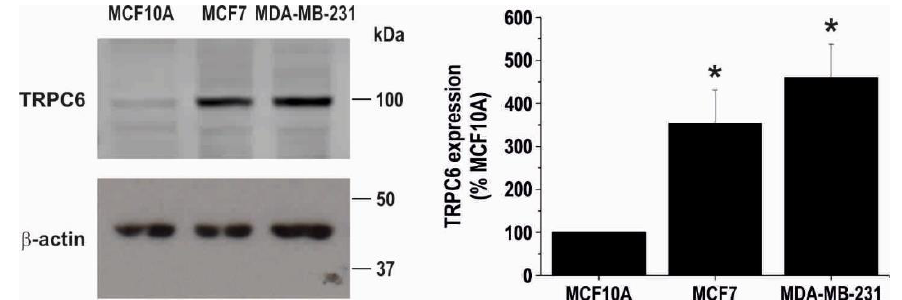
Figure 1. Cellular expression of TRPC6 in non-tumoral and breast cancer cell lines. MCF10A, MCF7 and MDA-MB-231 cells were lysed and subjected to Western blotting with anti-TRPC6 antibody, followed by reprobing with anti- β -actin antibody for protein loading control. Bar graphs represent TRPC6 expression normalized to the β -actin content and expressed as percentage of the TRPC6 expression in non-tumoral MCF10A cells. Molecular masses indicated on the right were determined using molecular-mass markers run in the same gel. * p < 0.05 compared to TRPC6 expression in MCF10A cells.